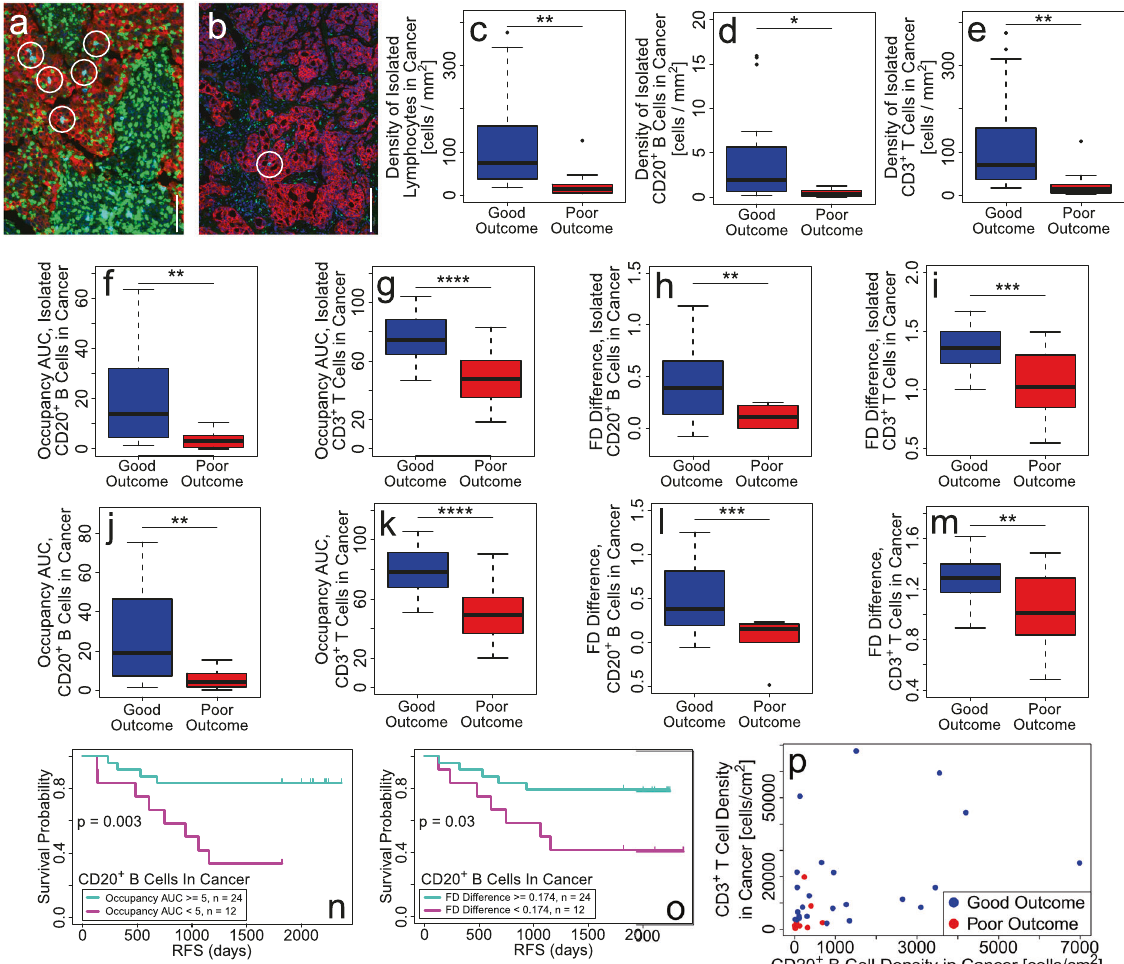
Fig. 4 Density and spatial dispersion of B and T cells in fi ltrating cancer cell islands are higher in good outcome. a , b Examples of CD20 + B cells (circled) within cancer cell islands in ( a ) good (scale bar = 100 μ m) and ( b ) poor outcome tumors (scale bar = 200 μ m). Color code: T cells (CD3 + ; green), B cells (CD20 + ; cyan), cancer cells (Pan-cytokeratin cells; dark brownish red), and nuclei (DAPI; dark blue). Scale bar = 100 μ m ( a ), 200 μ m ( b ). c – e Plots showing density of isolated ( c ) lymphocytes, ( d ) CD20 + B cells and ( e ) CD3 + T cells in fi ltrating cancer cell islands is higher for good ( n = 24) vs. poor ( n = 12) outcome tumors. f – g Plots showing occupancy AUC of isolated ( f ) B cells and ( g ) CD3 + T cells in fi ltrating cancer cell islands is higher for good ( n = 24) vs. poor ( n = 12) outcome tumors. h – i Plots showing FD difference of isolated ( h ) B cells and ( i ) CD3 + T cells in fi ltrating cancer cell islands is higher for good ( n = 24) vs. poor ( n = 12) outcome tumors. j – o B and T cells (including both isolated and LC lymphocytes) are more spread out within cancer cell islands in the good outcome: Plots showing occupancy AUC of ( j ) CD20 + B cells and ( k ) CD3 + T cells within cancer cell islands is higher in good outcome (B cells: p = 3 × 10 − 3 ; T cells: p = 6 × 10 − 5 ). Plots showing FD difference of ( l ) CD20 + B and ( m ) CD3 + T cells within cancer cell islands is higher for good vs. poor outcome (B cells: p = 8 × 10 − 4 ; T cells: p = 2 × 10 − 3 ). n RFS plots showing the clinical signi fi cance of occupancy AUC of CD20 + B cells within cancer cell islands with a threshold value = 5 corresponding to the fraction of poor outcome patients. o RFS plot showing the clinical signi fi cance of FD difference of CD20 + B cells within cancer cell islands with a threshold value = 0.174 (see “ Methods ” ). p Densities of B and T cells (both isolated and in LCs) within cancer islands are signi fi cantly correlated (Pearson r = 0.45, p = 0.006) even if no distinction is made between good and poor outcome. For all box-and-whisker plots, the center line represents the median, box limits represent the upper and lower quartiles, whiskers indicate maximum and minimum values within 1.5 interquartile ranges of the upper and lower quartiles; individual points are outliers. P -values in box plots are determined by unpaired, two-tailed Student t -tests. ns: not signi fi cant; * p < 0.05; ** p < 0.01; *** p < 0.001; **** p < 1 × 10 − 4